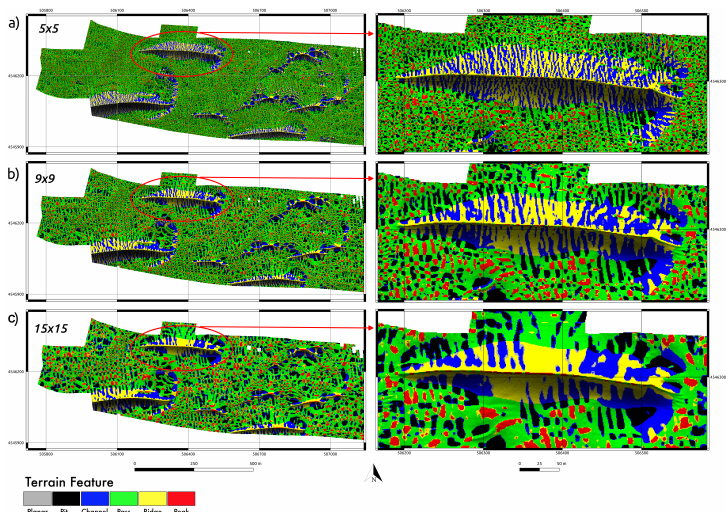
Figure 26. Output details of Model A for small value of curvature tolerance ( ct = 0.0001) for different sizes (15 ( a ); 9 ( b ); and 5 ( c )) of the window operator; the other parameters used were: exponent for distance weighting: 0.0; vertical scale factor: 0.5; and slope tolerance: 2.6. The zoomed areas on the right size of the image refer to the bedform labeled “1” in Figure 5.